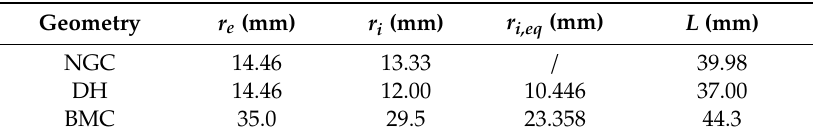
Table 1. Main geometrical parameters of the three geometries. The equivalent internal radius, obtained from the Couette analogy procedure described in the text, is also reported for the two non-conventional geometries.